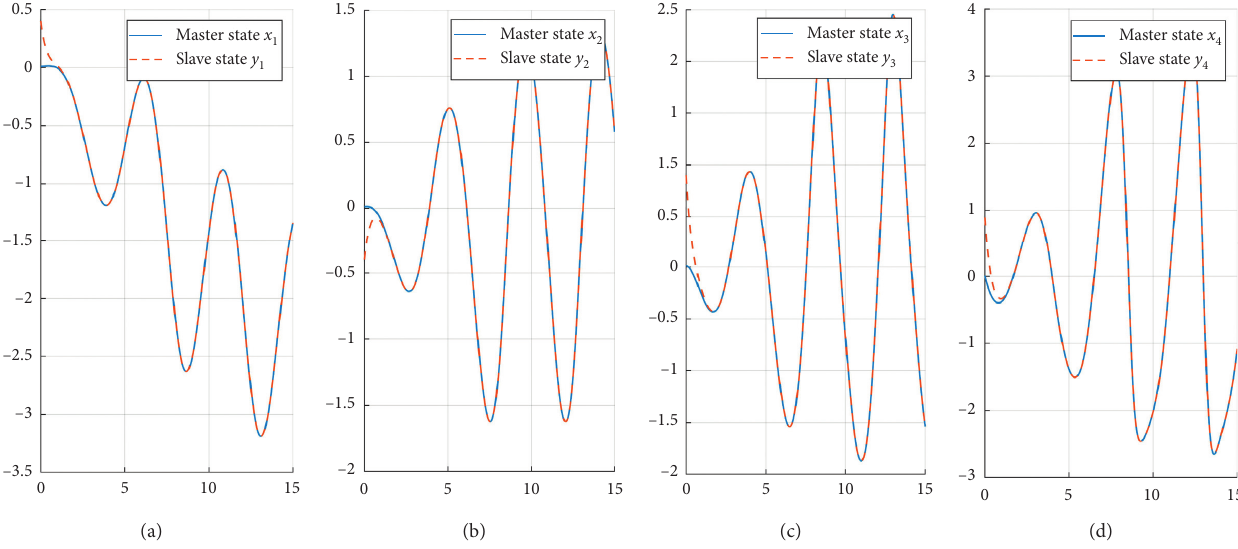
Figure 7: Synchronization between hyperjerk system (2) and hyperchaotic R¨ossler systems, for parameter values a � 1 . 4 , b � 3 , c � 1 . 2 , and d � 0 . 85 and b ( y